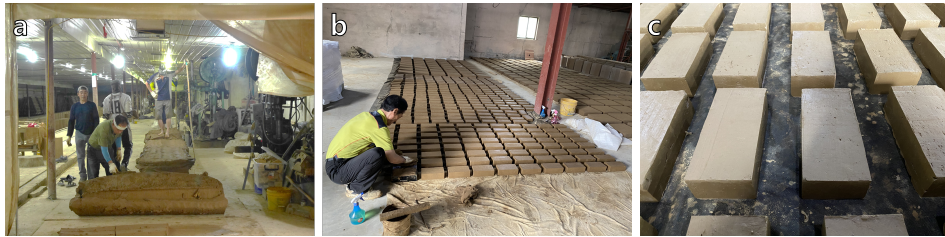
Figure 5. Traditional handmade bricks manufacturing process. ( a ) The soiling process using man- power. ( b ) Handmade bricks processed with a mold. ( c ) Demolded